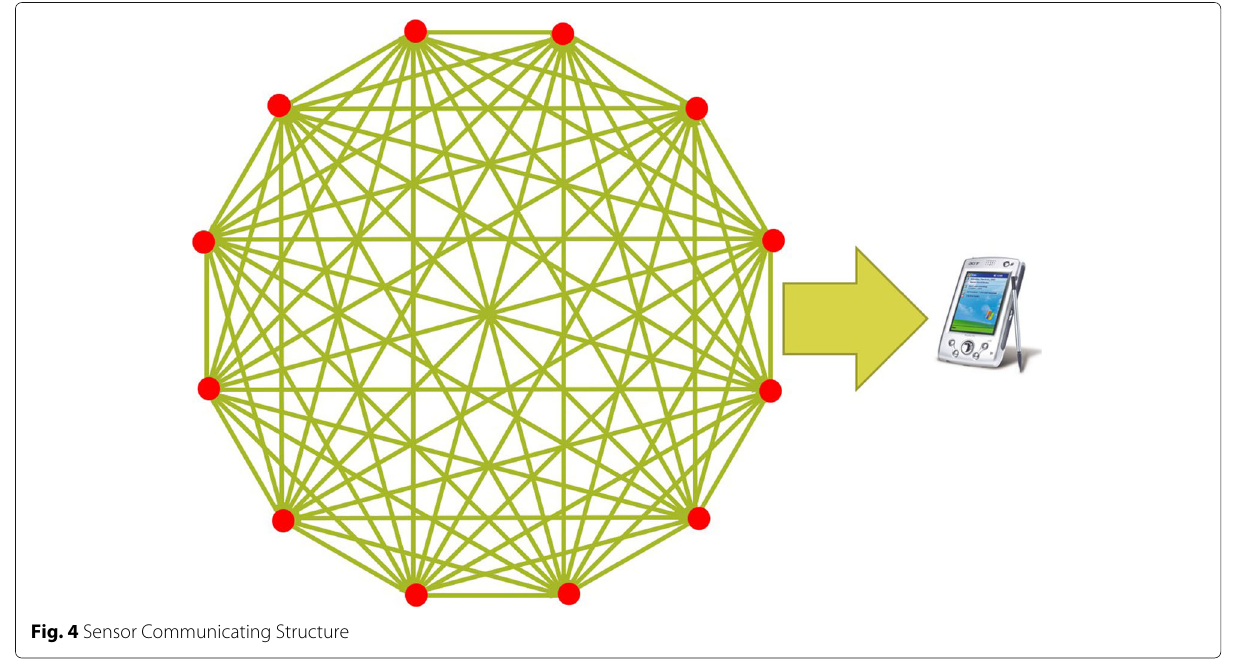
Fig. 4 Sensor Communicating